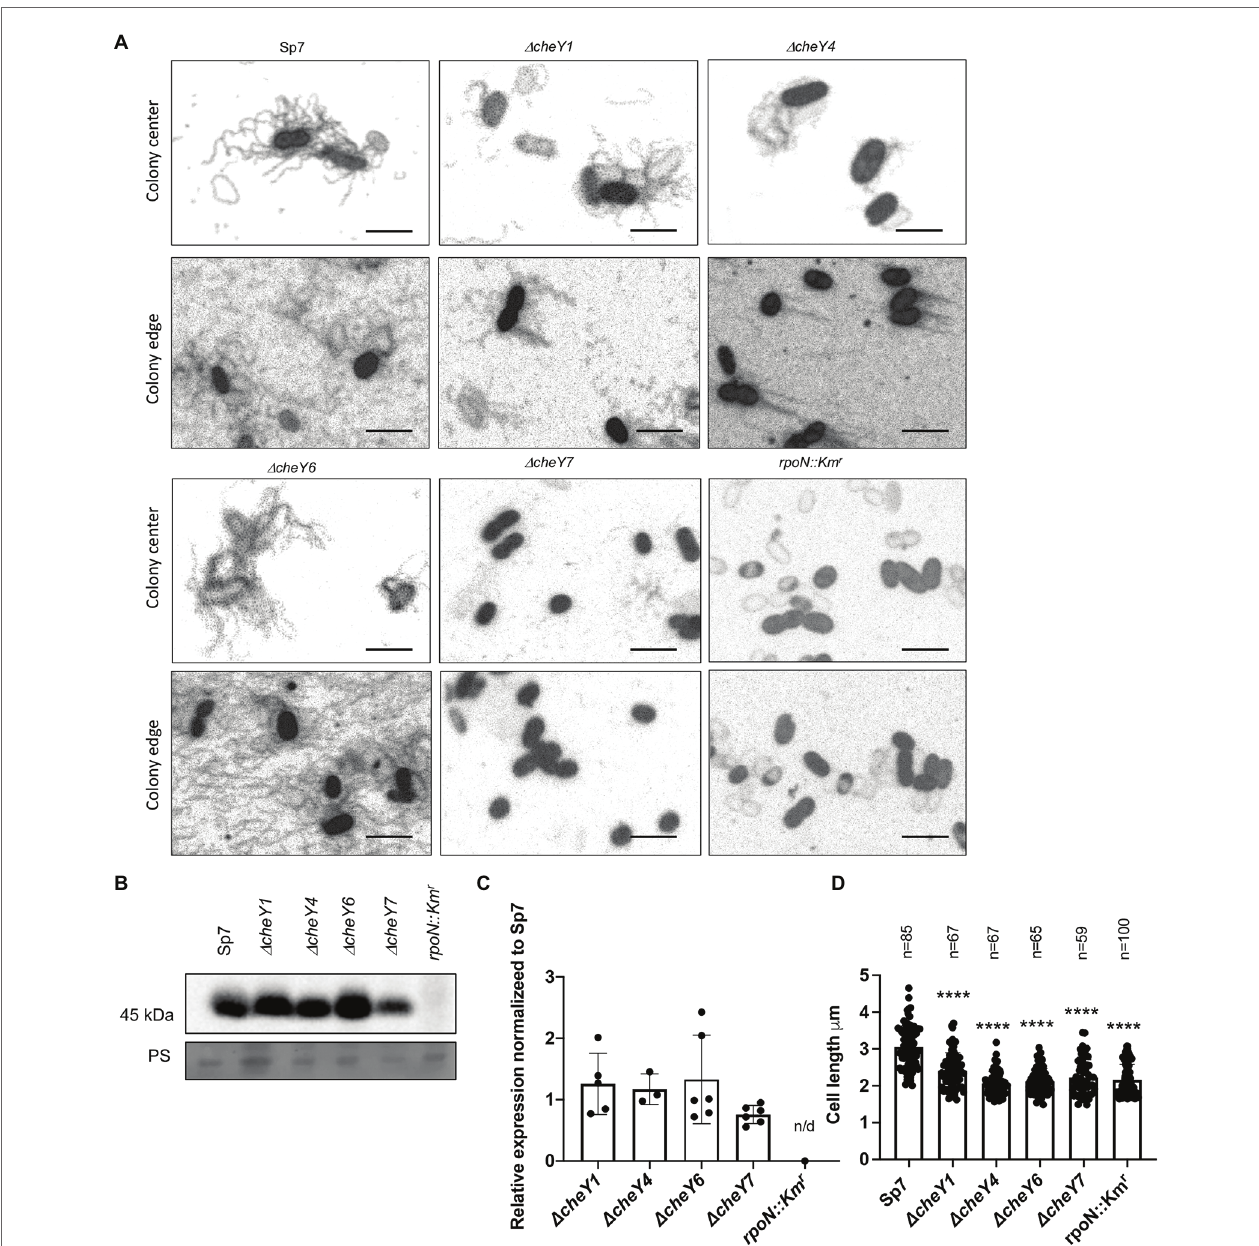
FIGURE 7 | Detection of lateral flagella produced in swarming colonies of A. brasilense Sp7 and mutant response regulator strains. (A) Representative images of separate cells within and at the edge of a swarming colony. Arrows indicate lateral flagella. (B) Western blot analysis with anti-lateral flagellin (1:1,000) polyclonal antisera of whole-cell preparations of A. brasilense Sp7, ΔcheY1 , ΔcheY4 , ΔcheY6, ΔcheY7, and rpoN::Km r mutant strains. Coomassie staining is shown below for the loading control. (C) Quantitation of relative lateral flagellin levels normalized to levels in the wild type Sp7 strain. Student t -test was used to determine the significance between Sp7 and mutant strains. (D) Quantitation of the cell lengths of Sp7, ΔcheY1 , ΔcheY4 , ΔcheY6 , and ΔcheY7 mutant strains grown under swarming conditions. Student t -test was used to determine significance between Sp7 and mutant strains (**** p <